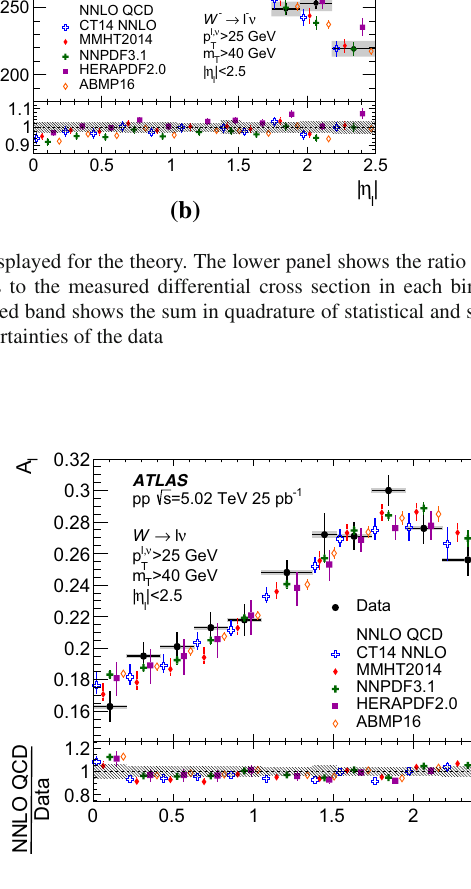
Fig. 13 Charge asymmetry for W bosons as a function of absolute decay lepton pseudorapidity compared with theoretical predictions. Statistical and systematic errors are shown as corresponding bars and shaded bands on the data points. Only the dominant uncertainty (PDF) is displayed for the theory. The lower panel shows the ratio of pre- dictions to the measured differential cross section in each bin, and the shaded band shows the sum in quadrature of statistical and systematic uncertainties of the data